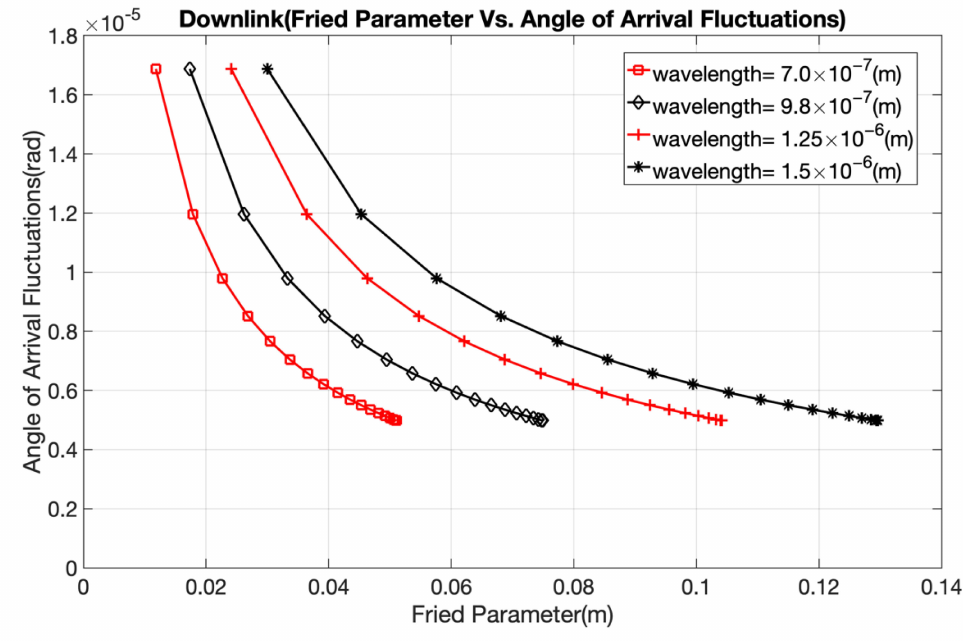
Figure 10. Variation in angle-of-arrival fluctuations (diameter = 0.10